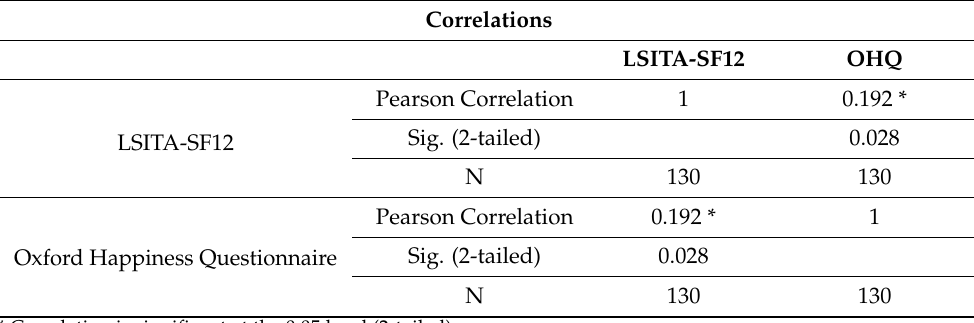
Table 3. The discriminant validity between 12 items Life Satisfaction Index for the Third Age—Short Form (LSITA-SF12) and the Oxford Happiness Questionnaire (OHQ).